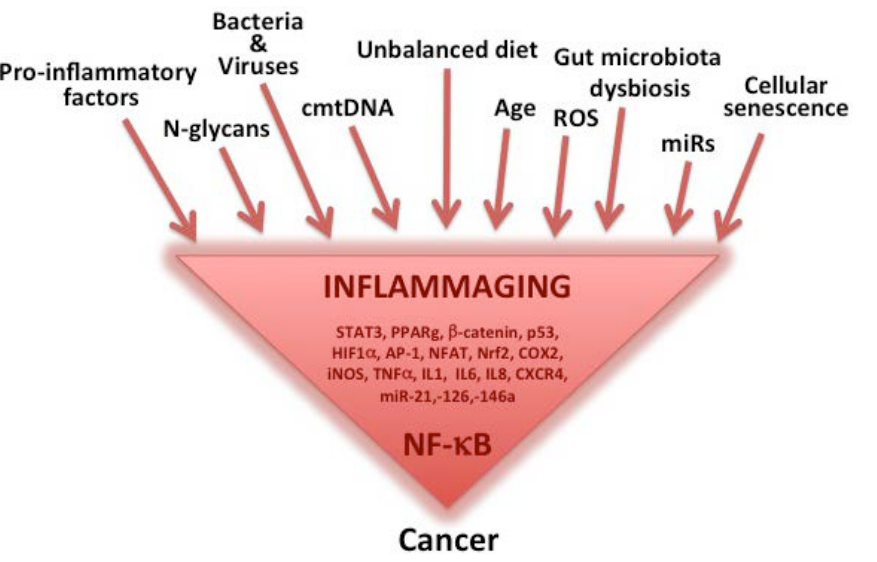
Figure 1. Among the main causes of inflammaging, we found the accumulation of pro-inflammatory factors, viruses and bacteria, age, reactive oxygen species (ROS) and cellular senescence. Inflammaging can also be influenced by many other factors, including non-immunological ones, and those not directly related to inflammation, such as microRNAs (miRs), circulating mitochondrial DNA (cmtDNA) and agalactosylated N -glycans, together with the products and related metabolites of the intestinal microbiota. Several pathways and molecules are triggered by these factors, which then are able to activate the nuclear transcription factor NF-κB which could be considered as a hub in carcinogenesis, linking inflammaging, cellular senescence and